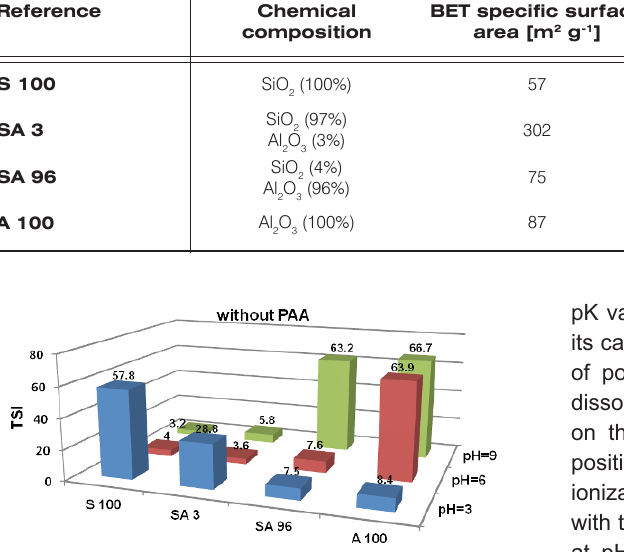
Figure 1. TSI values for the suspensions of various adsorbents without PAA at different pH values.